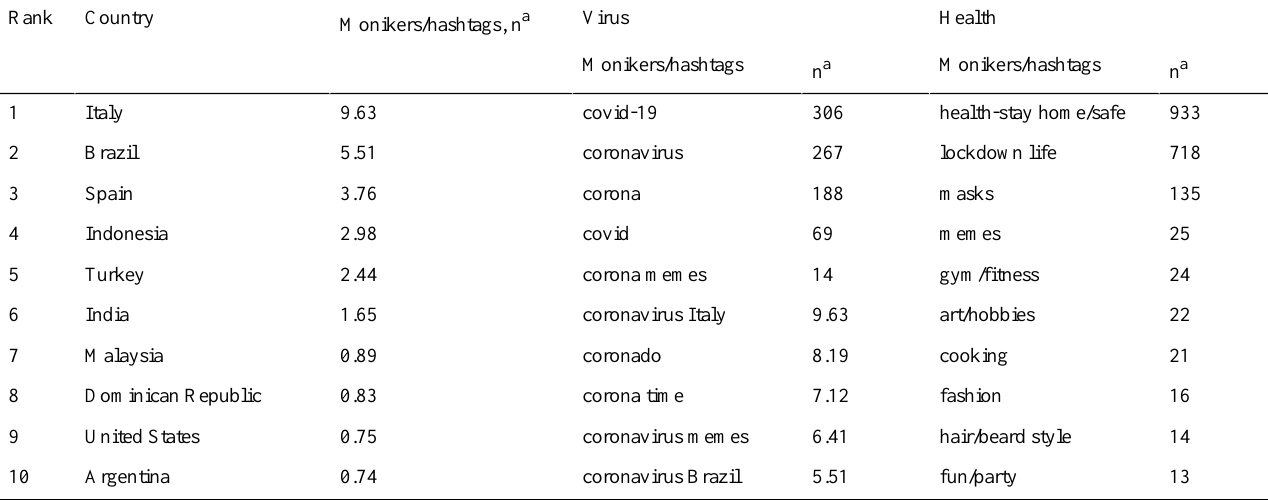
Table 3. Top 10 Instagram hashtags related to coronavirus disease (COVID-19), as of May 6, 2020.